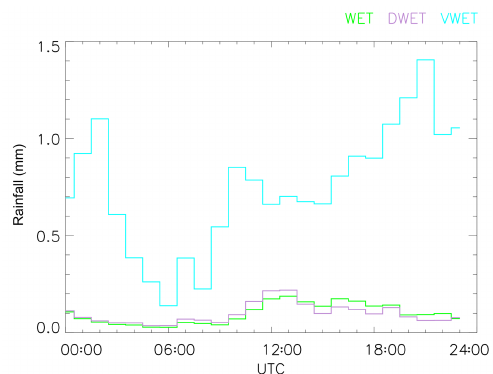
Figure 5. The average rainfall for each hour of the day, for VWET days (cyan), WET days (green) and DWET days (purple). In this and later plots, time is shown as UTC (coordinated universal time), which is 2h behind LT (local time), i.e. LT = UTC +